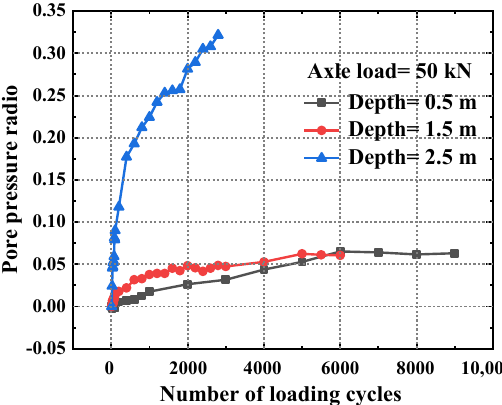
Figure 10. Pore-pressure ratio under 50 kN axial load.